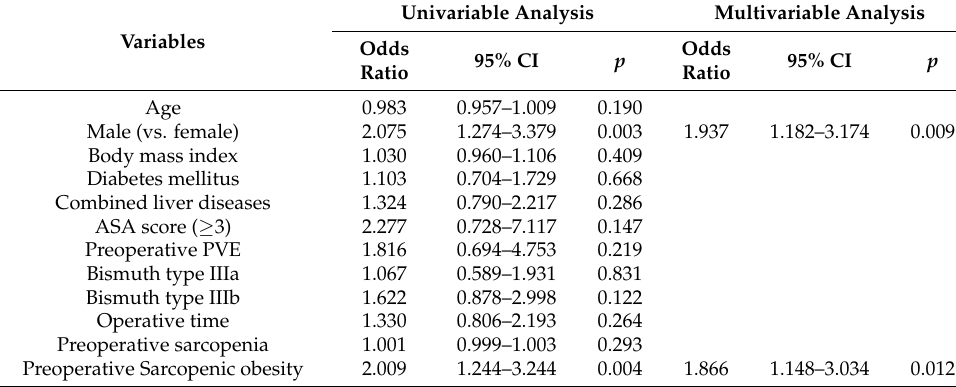
Table 3. Risk factor analysis for major complications.